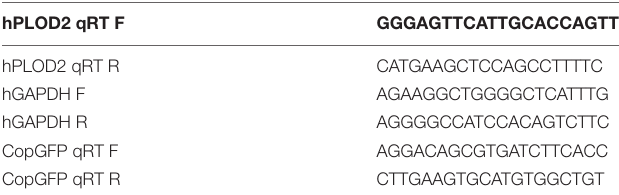
TABLE 1 | Primers for